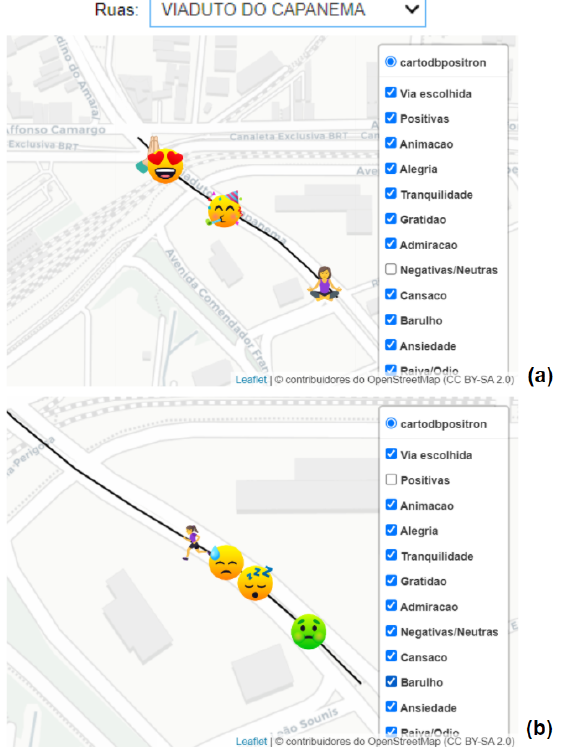
Figure 8 . (a) Viaduto do Capanema assigned with positive emotions. (b) Viaduto do Capanema assigned with negative/neutral emotions.